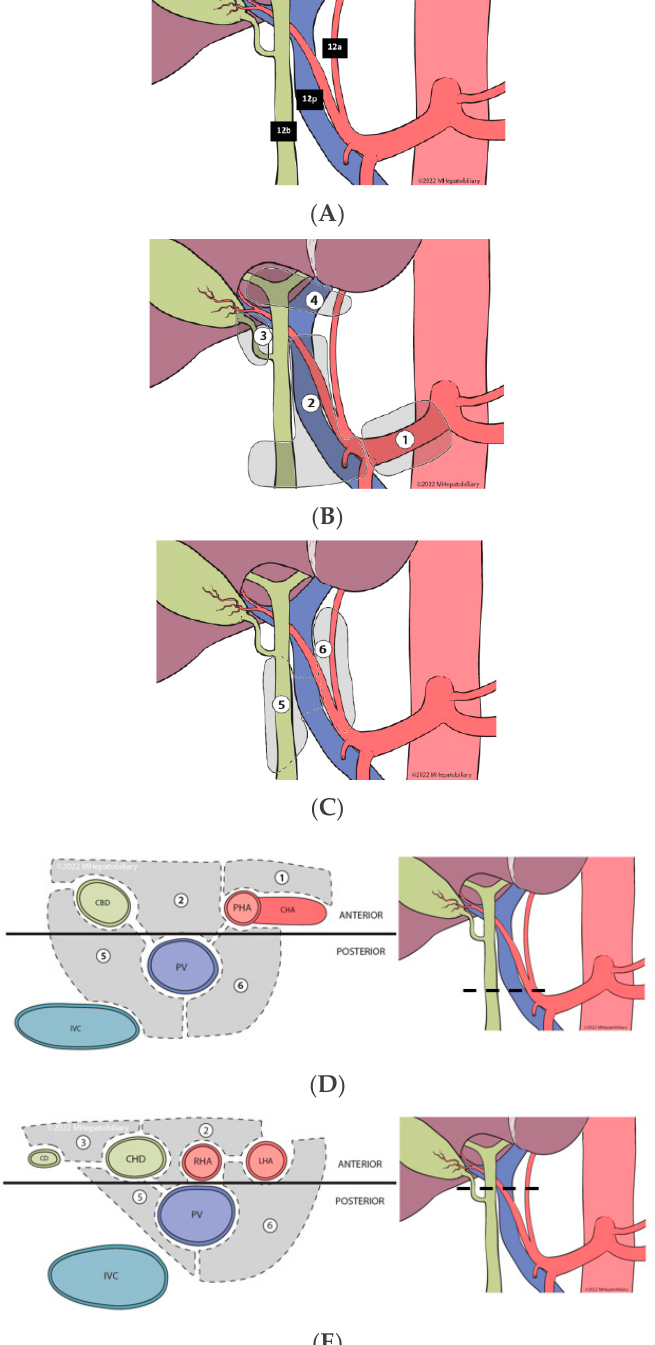
Figure 1. ( A ). Anatomy of intra-abdominal nodal stations defined by the Japanese gastric cancer designation. ( B ). Localization of anterior lymphatic substations of the hepatoduodenal ligament— coronal plane. ( C ). Localization of posterior lymphatic substations of the hepatoduodenal ligament and their relation to the portal vein—coronal plane. ( D ). Axial view of the most caudal portion of the hepatoduodenal ligament—with designation of anterior and posterior lymphatic substations— divided by a coronal line across the anterior surface of the portal vein. ( E ). Axial view of the most cephalad portion of the hepatoduodenal ligament—with designation of anterior and posterior lymphatic substations—divided by a coronal line across the anterior surface of the portal vein.